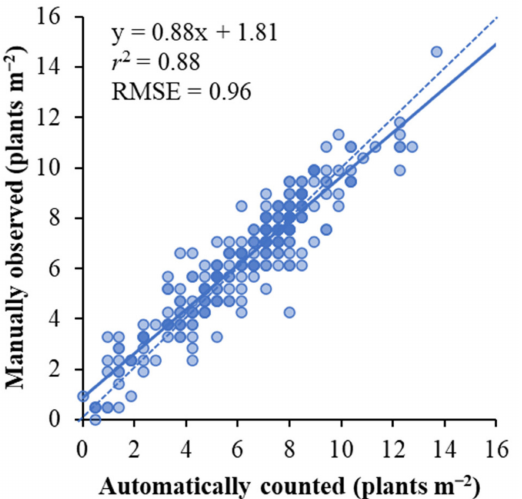
Figure 5. Relationship between manually observed and automatically counted soybean plant density (plants m − 2 ) in the YOLOv3 best model with a confidence threshold value of 0.50 for the test dataset ( n = 248). The solid line represents a regression line. The dashed line represents a 1:1 reference